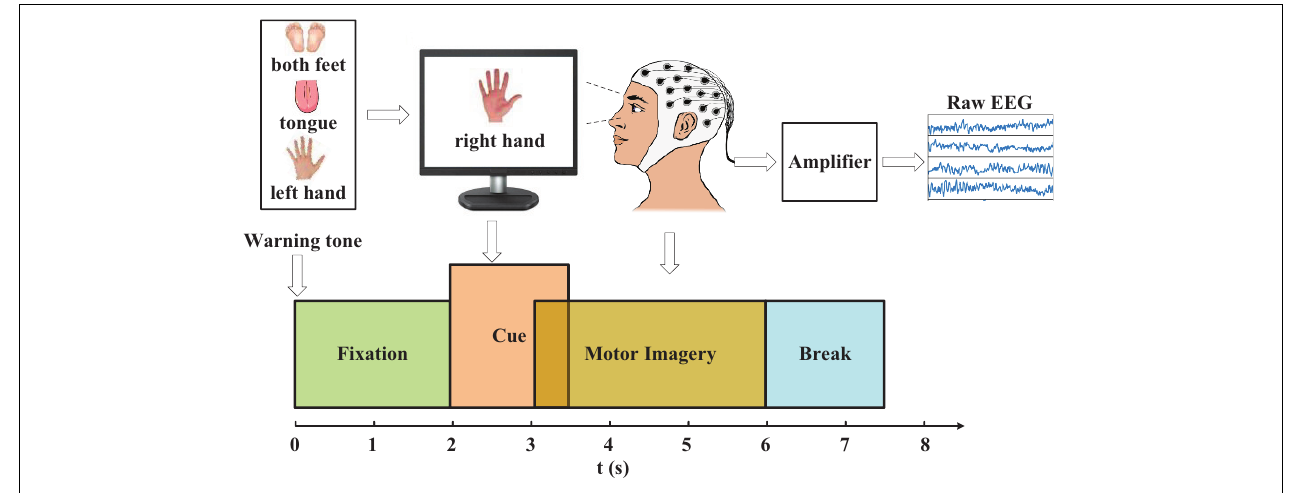
FIGURE 1 | The experimental paradigm. The recording was divided into 4 blocks: (1) 2s with eyes open (looking at a fixation cross on the screen) after a warning tone, (2) A visual cue of different MI task appeared on the screen for 1.5 s (3) The subjects were asked to carry out the motor imagery task until the cue of MI finished at t = 6s. (4) A short break